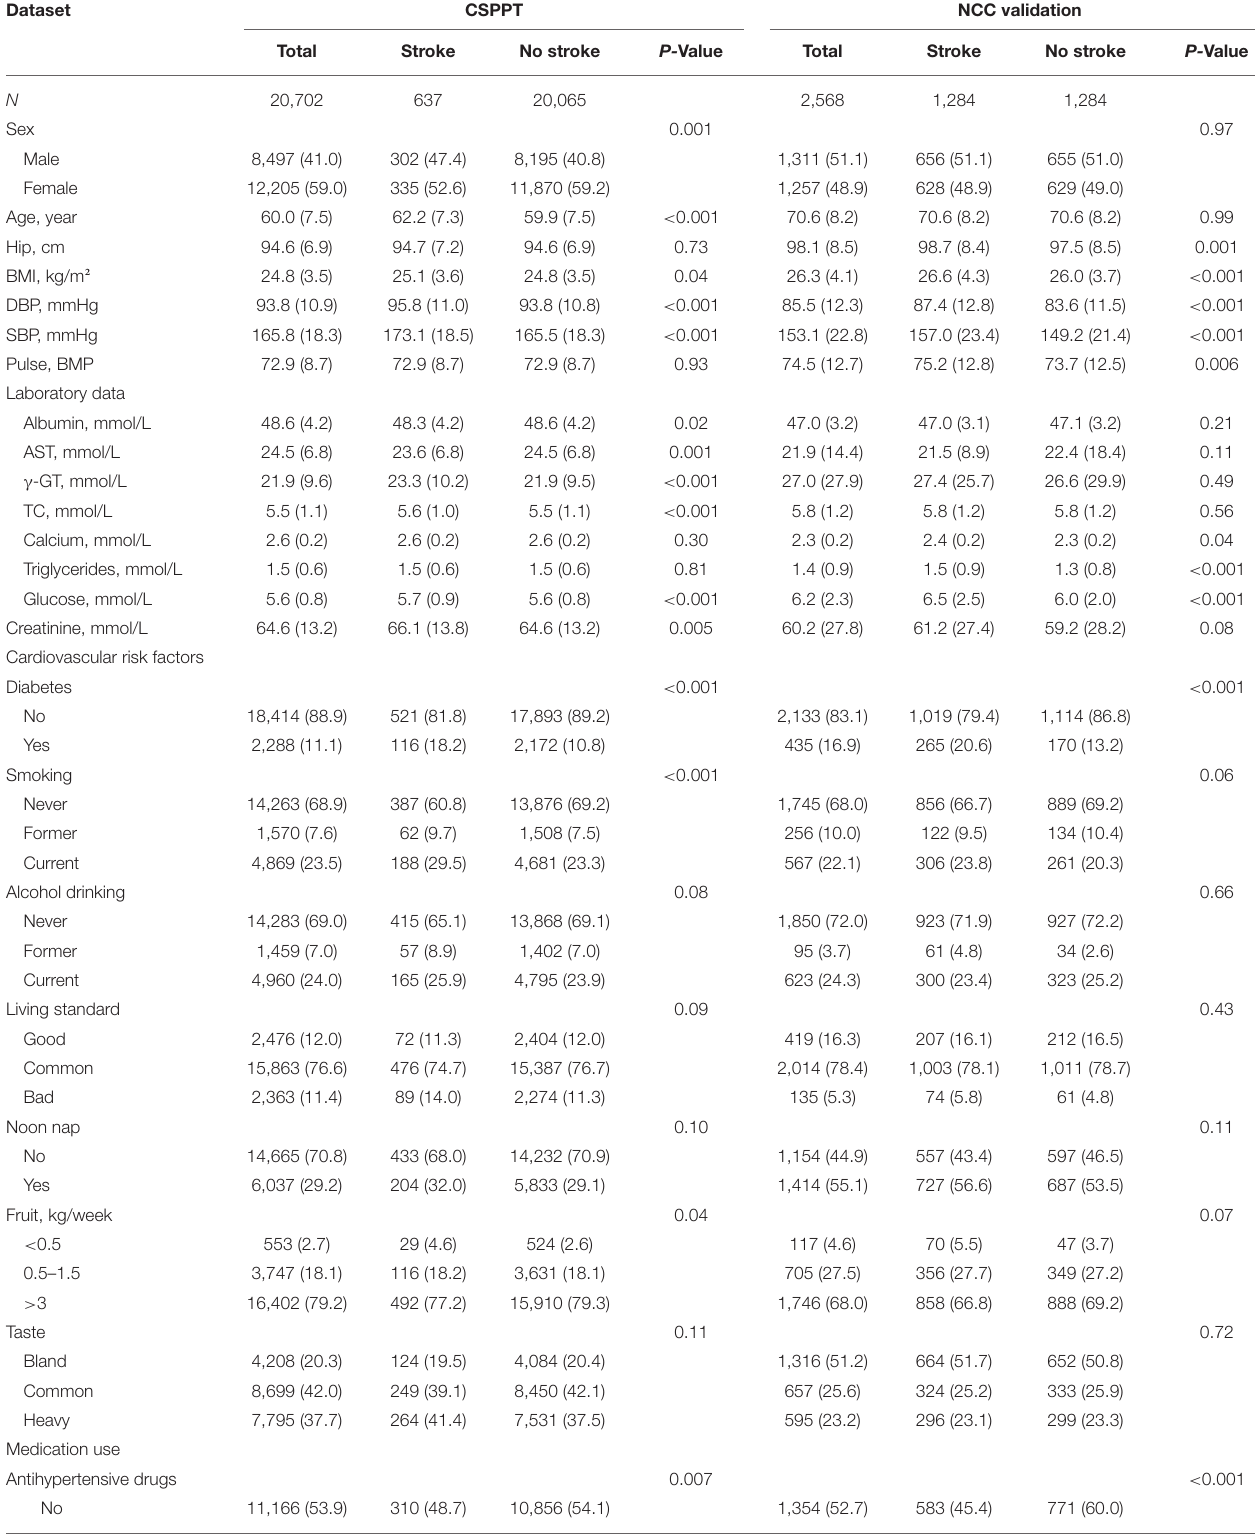
TABLE 1 | Baseline and follow-up characteristics of the study participants.